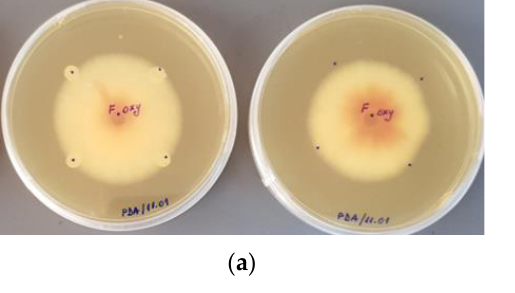
Figure 2. F. oxysporum grown after 5 days on PDA ( a ) and grown after 10 days on PDA ( b ). In the presence of the solvent 10% DMSO with 0.5% Tween 80 (at left), without the solvent (at right). Plates were sealed with parafilm, incubated at 26 to 28 °C and analyzed on a daily